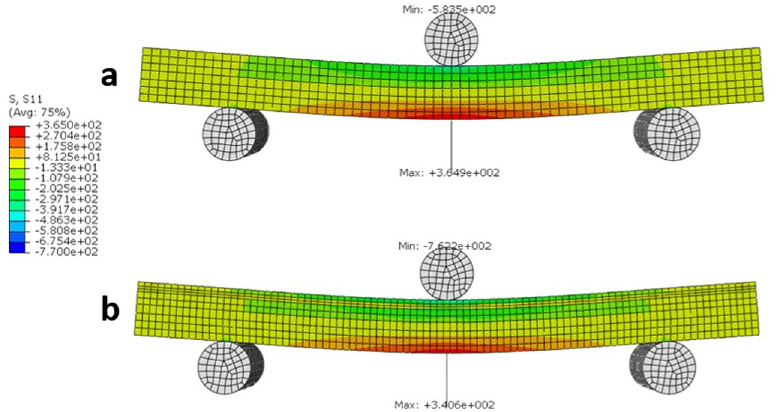
Fig 9. Longitudinal stress S11 (MPa) distribution for a) non-Wormian bone model, b) Wormian bone model. The maximum longitudinal stress for the Wormian model is ~7% lower than the non-Wormian model.